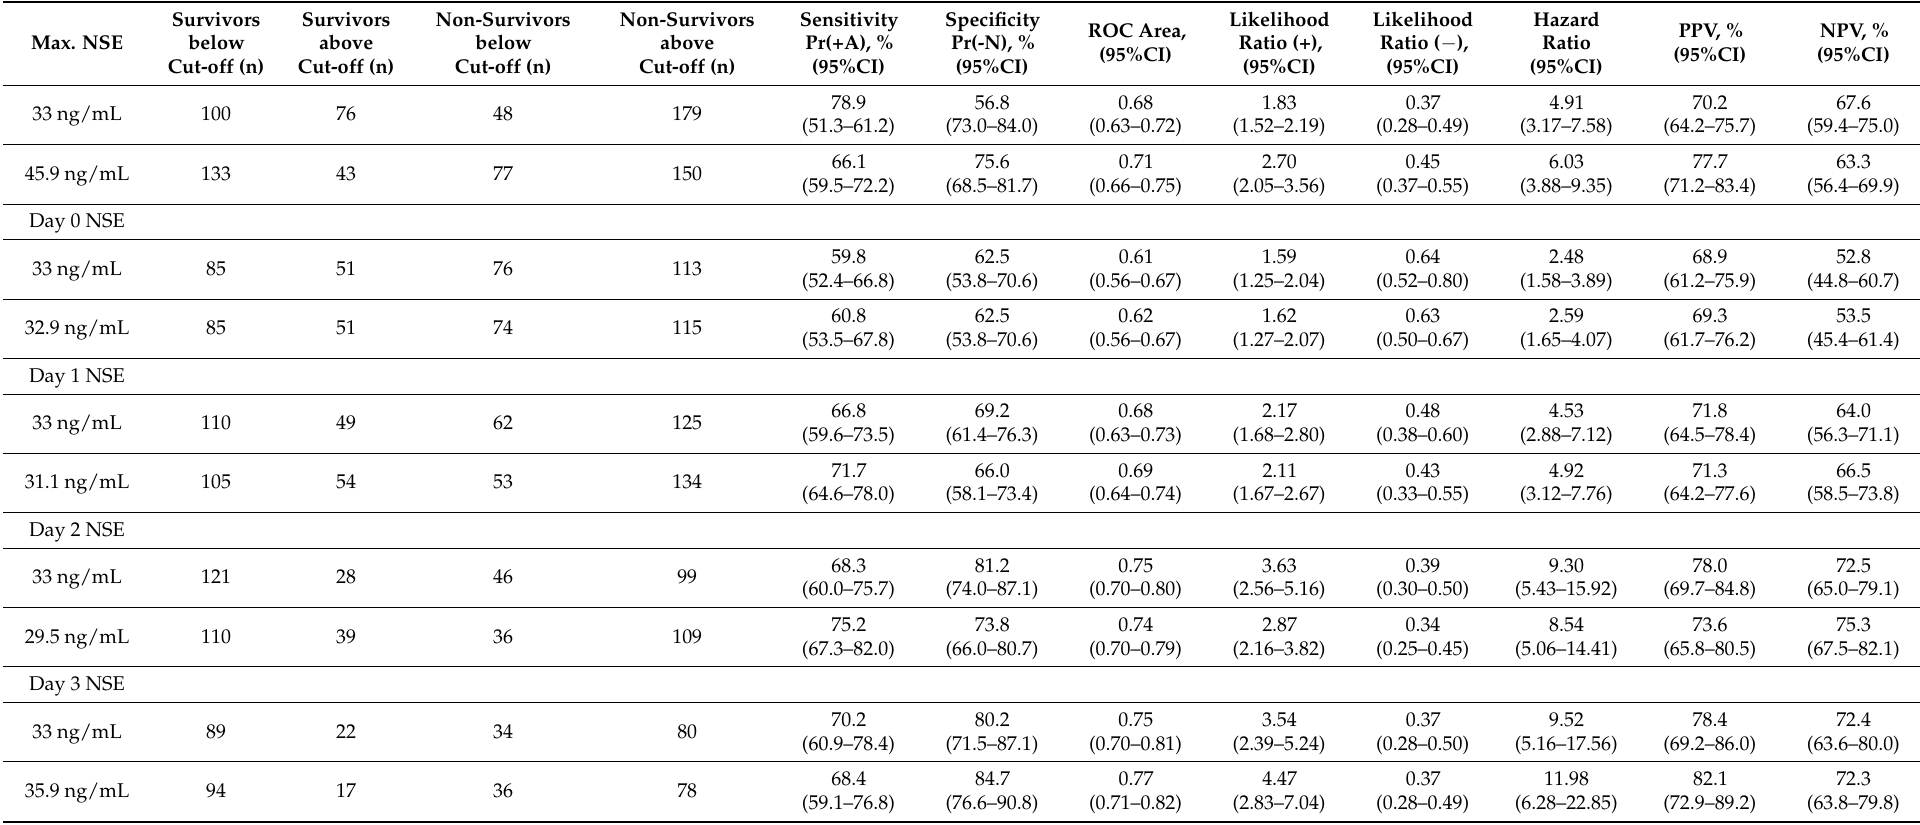
Table 3. Performance of NSE serum levels at different cut-off points to predict overall long-term